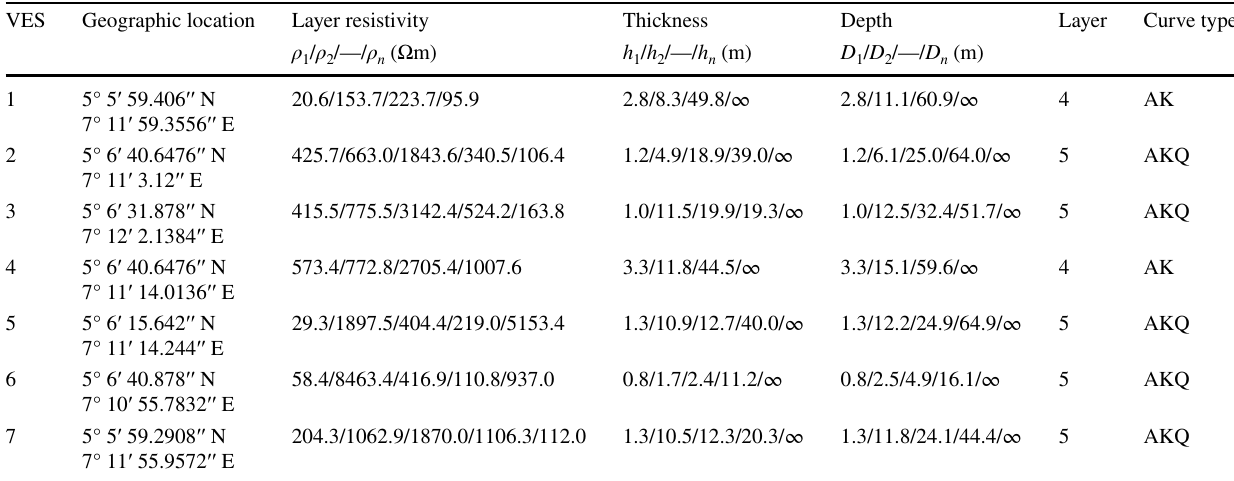
Table 1 Summary of VES result